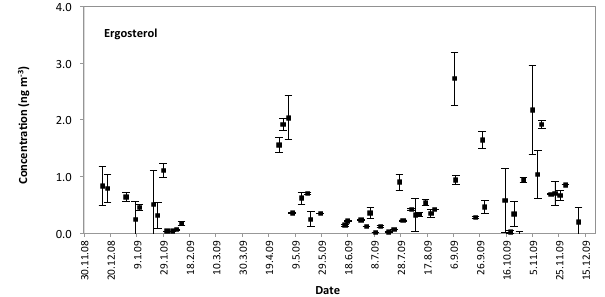
Fig. 4. Ergosterol concentration during 2009. High concentrations are seen during the autumn.